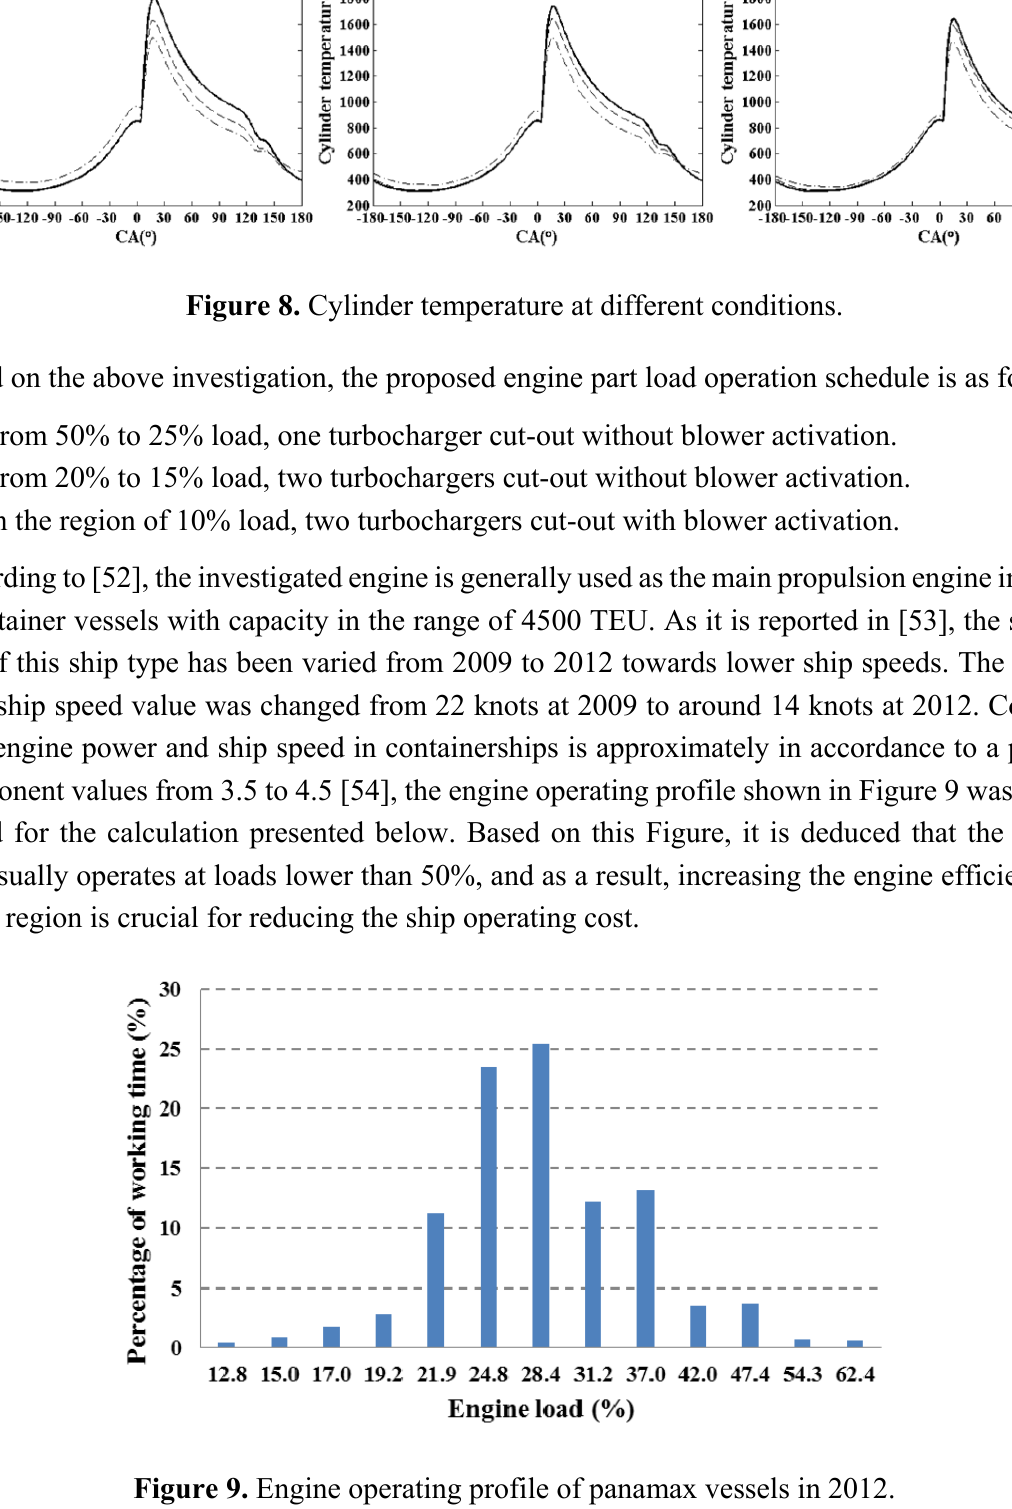
Figure 9. Engine operating profile of panamax vessels in